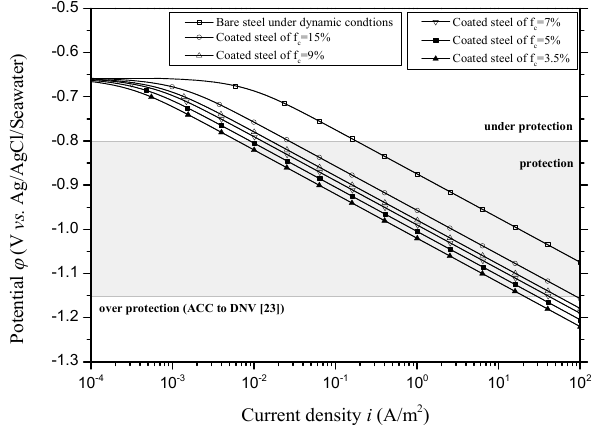
Figure 4. Polarization curves (only the cathodic branch) of coated steel in seawater for all adopted coating degradation conditions.